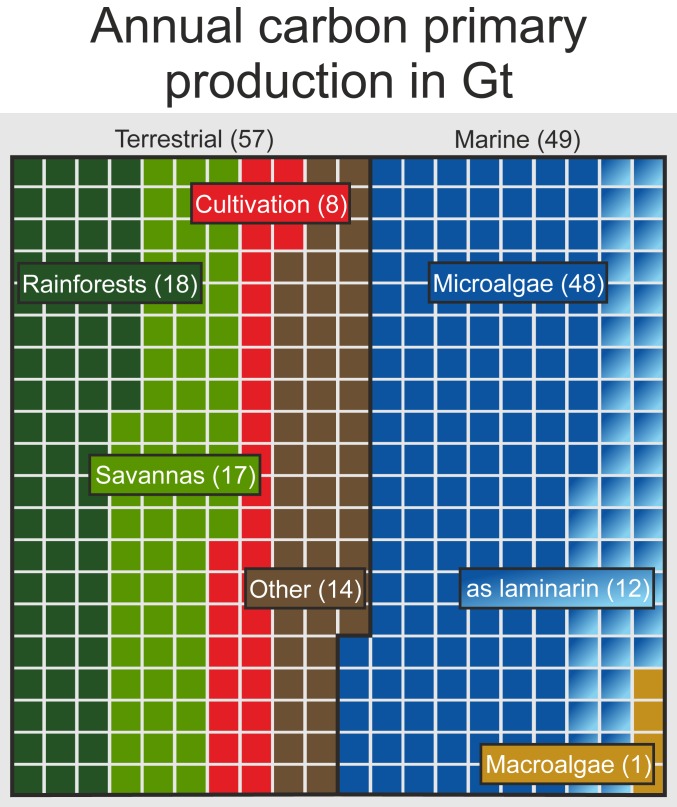
Net primary production (NPP) pools of carbon after Field et al. (1). Shown are major biological contributors from terrestrial and marine sources, normalized to 400 equal squares, each depicting ∼0.27 gigatons of carbon, which is annually being fixed by primary production; 12 ± 8% of the global carbon production is deposited in the form of the microalgal storage compound laminarin.